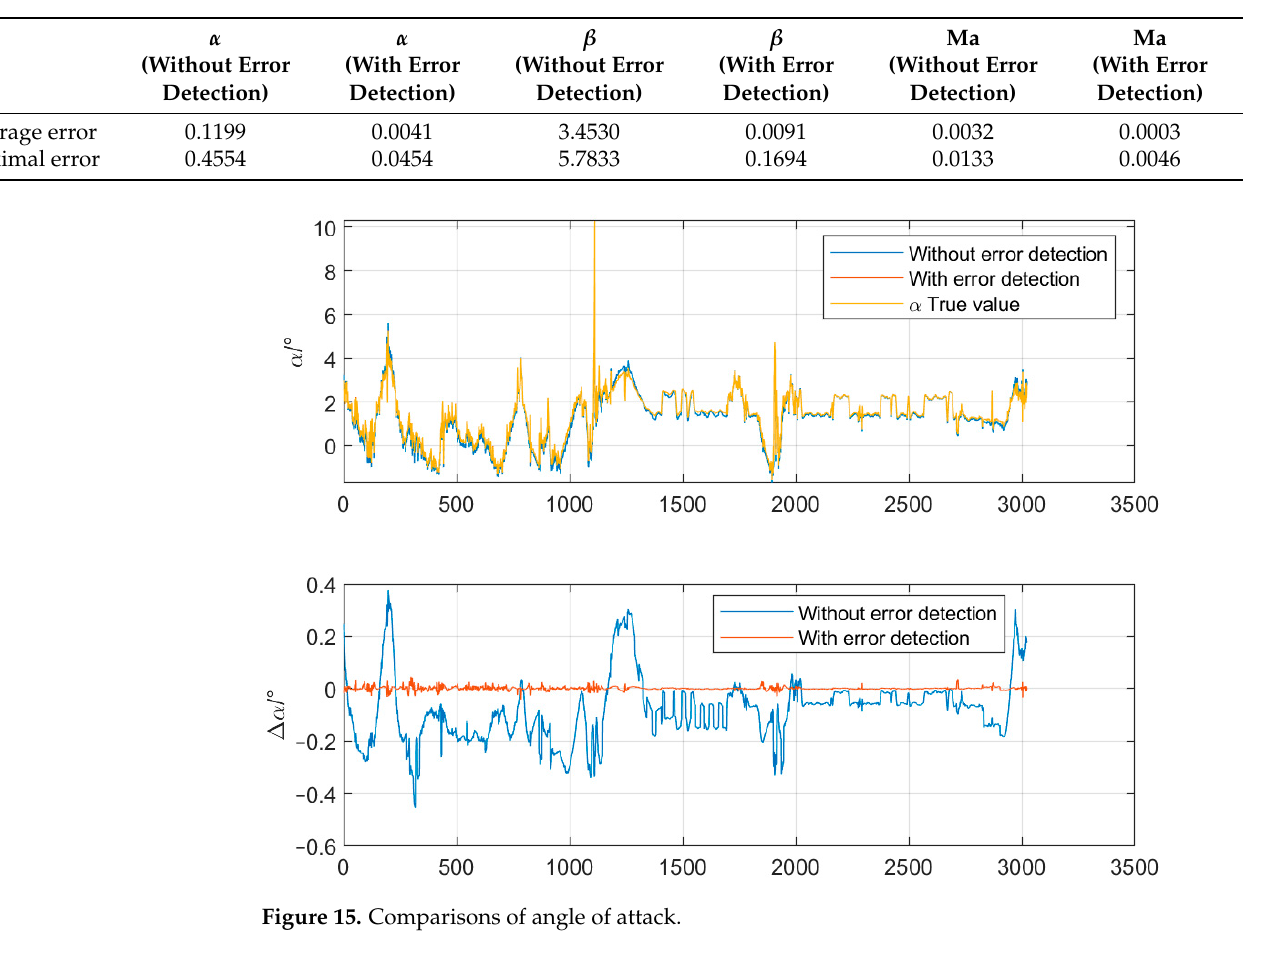
Figure 15. Comparisons of angle of attack.